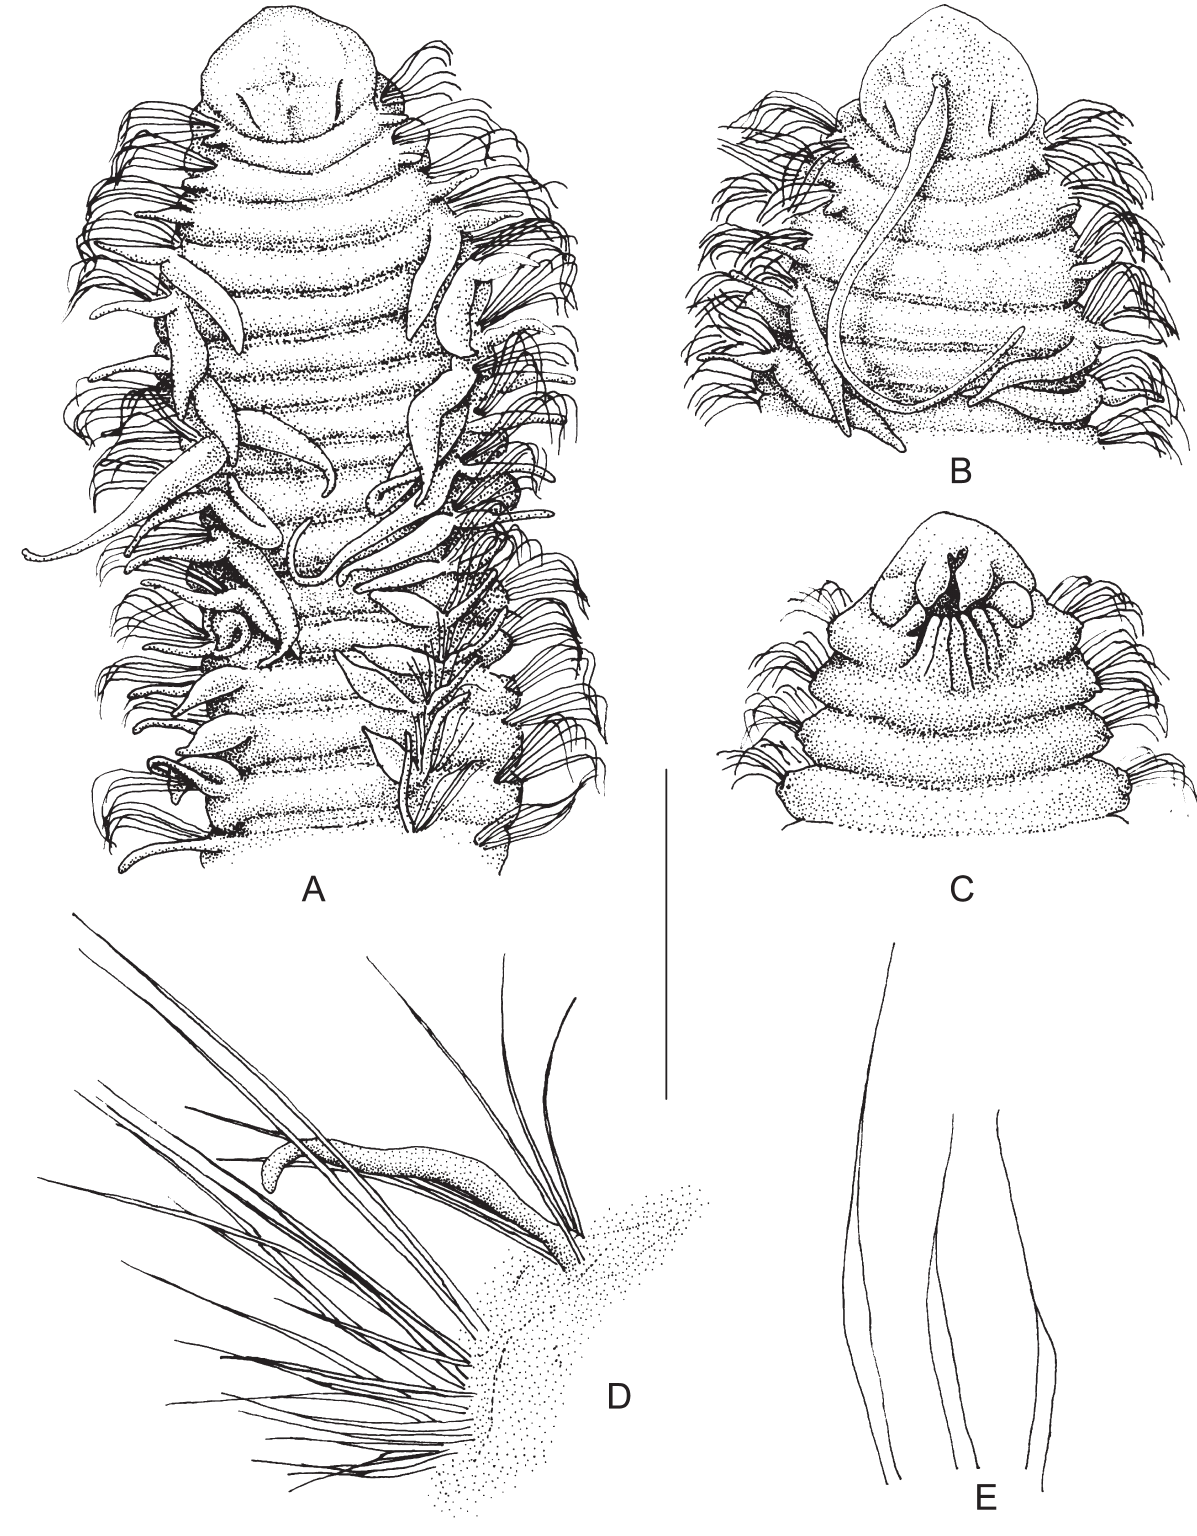
Fig . 20. – Aricidea ( Allia ) maialenae n. sp.: A, anterior region, dorsal view; b, anterior region, dorsal view; Holotype (Mncn 16.01/11211); c, anterior region, ventral view; D, parapodium, chaetiger 33; e, modified ventral chaeta, chaetiger 33. Scale bar: A 480 µ m; b 490 µ m; c 475 µ m; D 70 µ m; e 120 µ